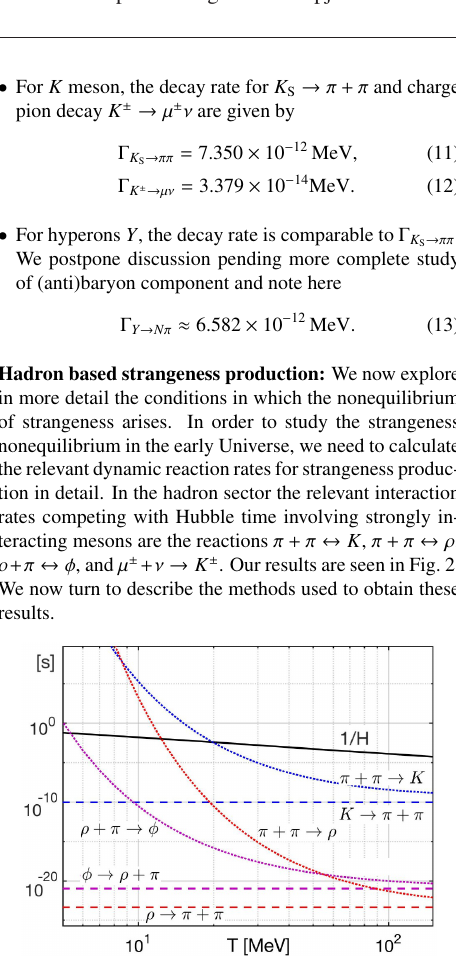
Figure 2. Hubble time 1 / H (black line) as a function of tem- perature is compared to hadronic relaxation reaction times, see ρ (red), K (blue), π + π Eq.(20), for reactions π + π ↔ ↔ ρ + π φ (purple). The horizontal dashed lines are the corre- ↔ sponding natural decay